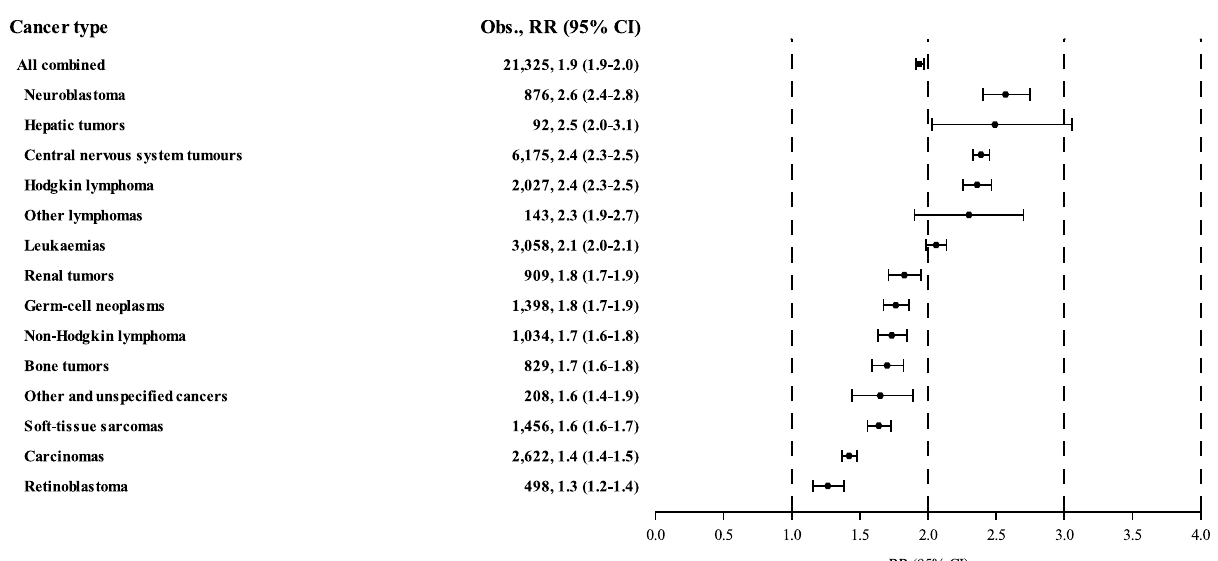
Fig 4. Standardised hospitalisation rate ratios (RRs) of survivors of all types of childhood cancers. 95% CI, 95% confidenceinterval; Obs., observed. SBDRs were seen for survivors of hepatic tumours (SBDR: 9.9), followed by survivors of leu- kaemia (SBDR: 8.9), neuroblastoma (SBDR: 8.4), and CNS tumours (SBDR: 6.9). Fig 5 shows that most of the days spent by cancer survivors in hospital were for cancer recurrences and new primary cancers (SBDR: 24.2), followed by diseases of the nervous system and sense organs (SBDR: 5.8), diseases of blood and blood-forming organs (SBDR: 4.2), and benign neo- plasms (SBDR: 3.4). The high overall SBDR for diseases of the nervous system and sense organs was due mainly to a particularly high SBDR of 15.9 (15.5–16.2) for epilepsy. Panels A—